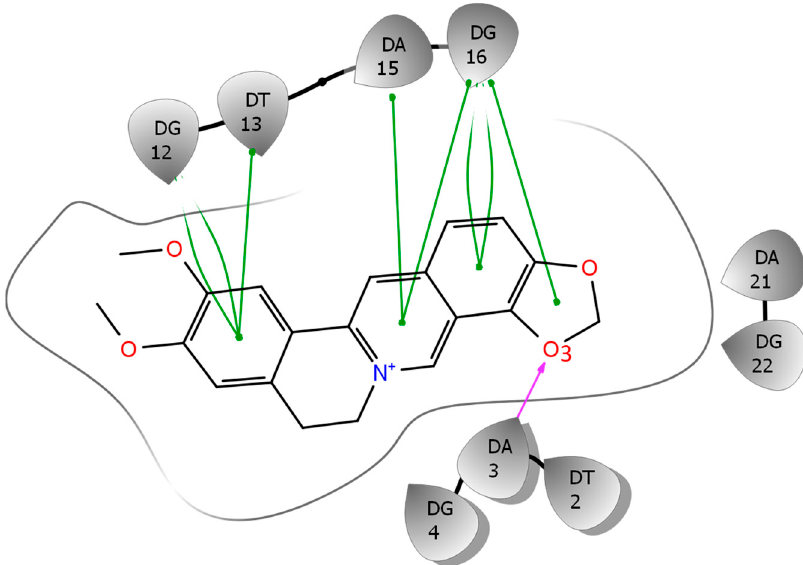
Figure 6. The ligand interaction diagram based on the NMR structure of the EPI-wtTel26 complex. The green lines represent stacking, and purple arrow indicates H-bonding interaction.